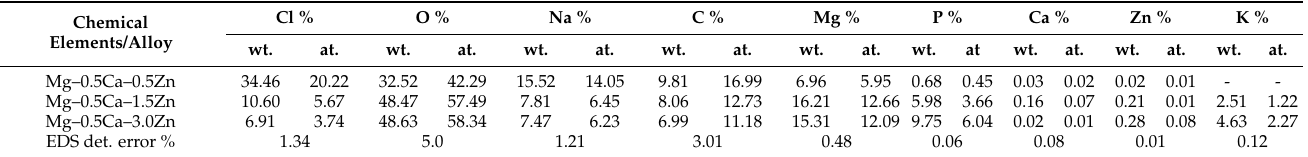
Table 6. Chemical composition of the compounds passed in the electrolyte